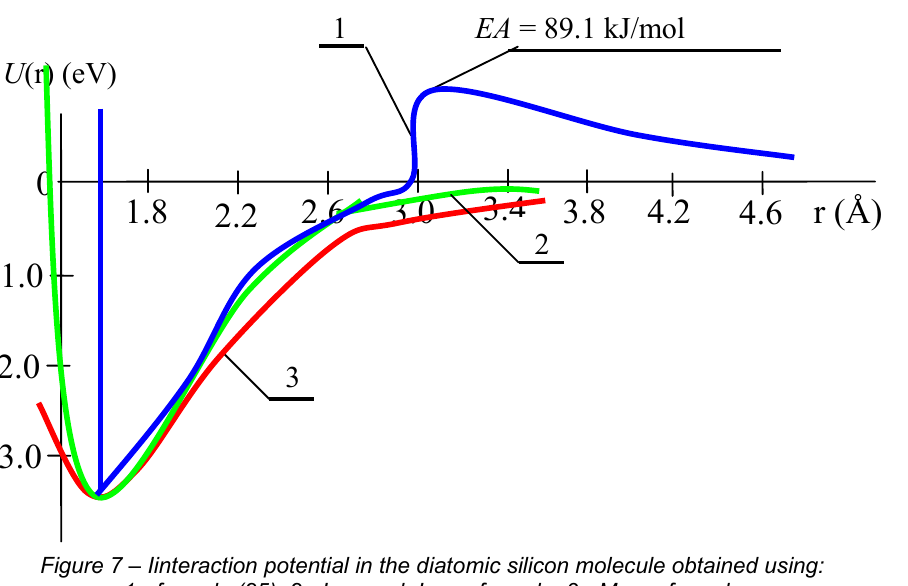
Figure 7 – Iinteraction potential in the diatomic silicon molecule obtained using: 1 - formula (25); 2 - Lennard-Jones formula; 3 - Morse